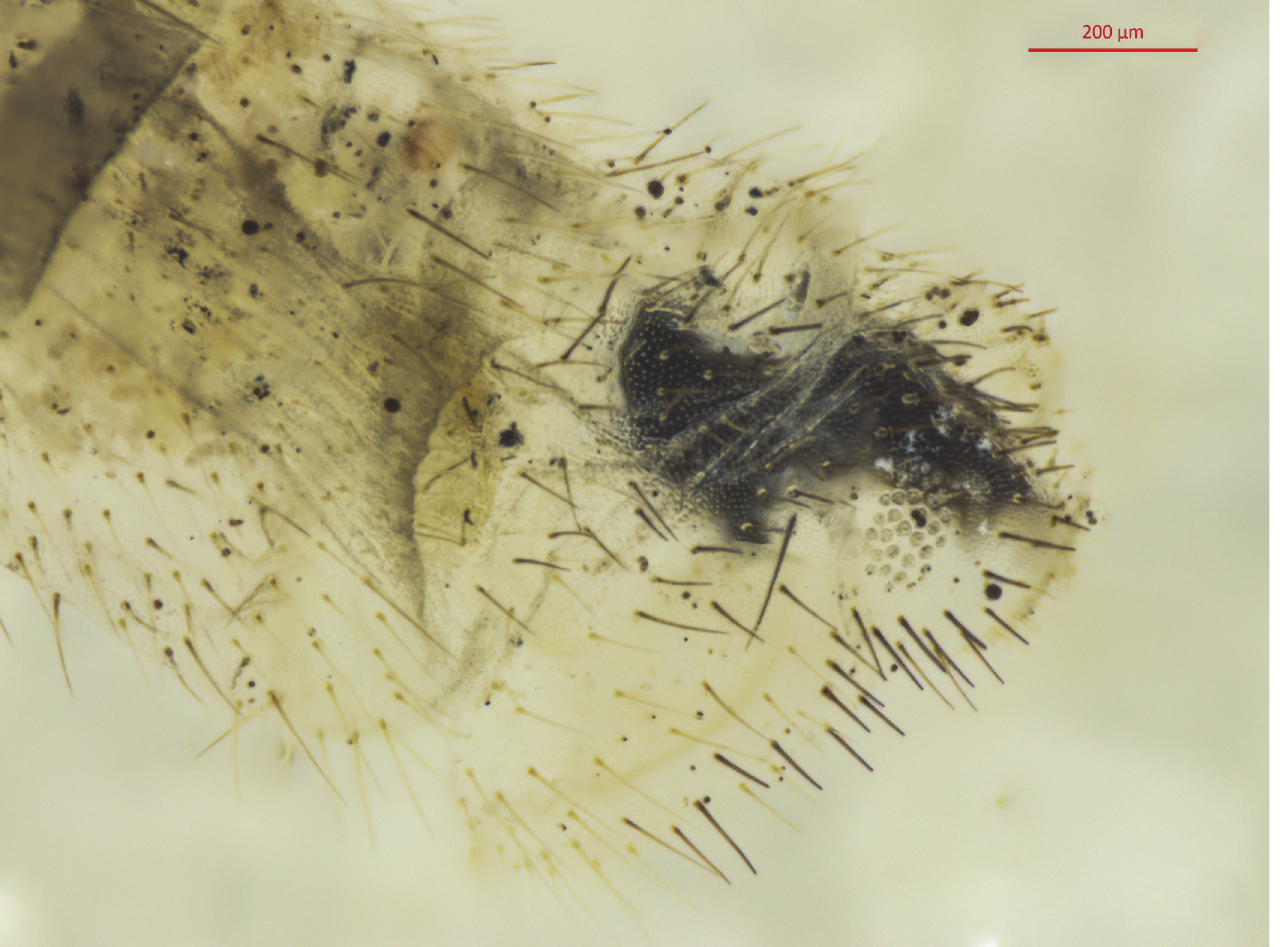
Fig 2. Terminalia of Chrysoperla carnea lectotype. Tip of abdomen is shown following DNA extraction.